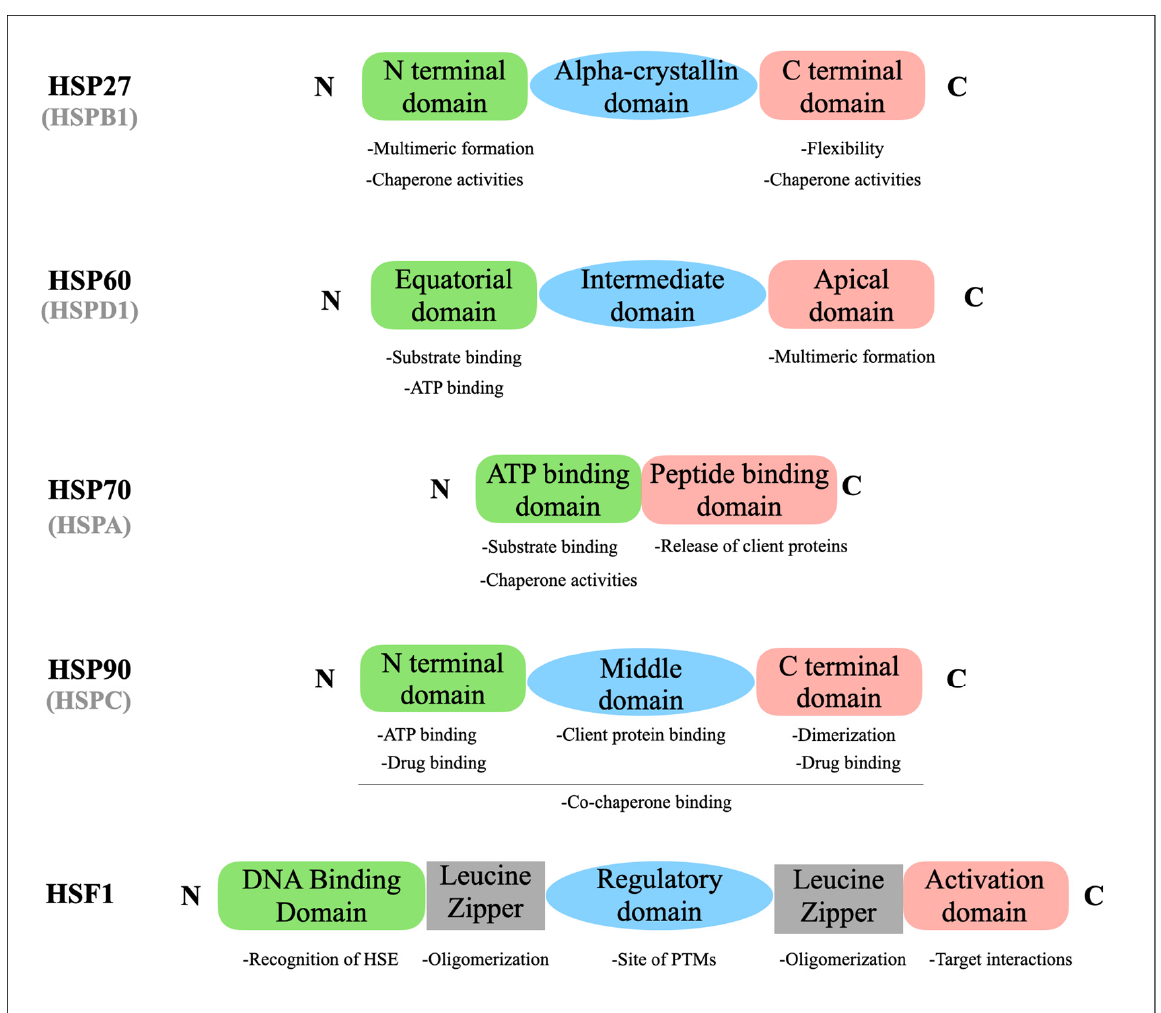
Figure 2. Schematic structure of HSP27 (HSPB1), HSP60 (HSPD1), HSP70 (HSPA), HSP90 (HSPC) and HSF1. The main functions of each domain are specified. HSP: Heat Shock Protein; HSF1: Heat Shock Factor 1; HSE: Heat Shock Element; PTMs: Post Translational Modifications.